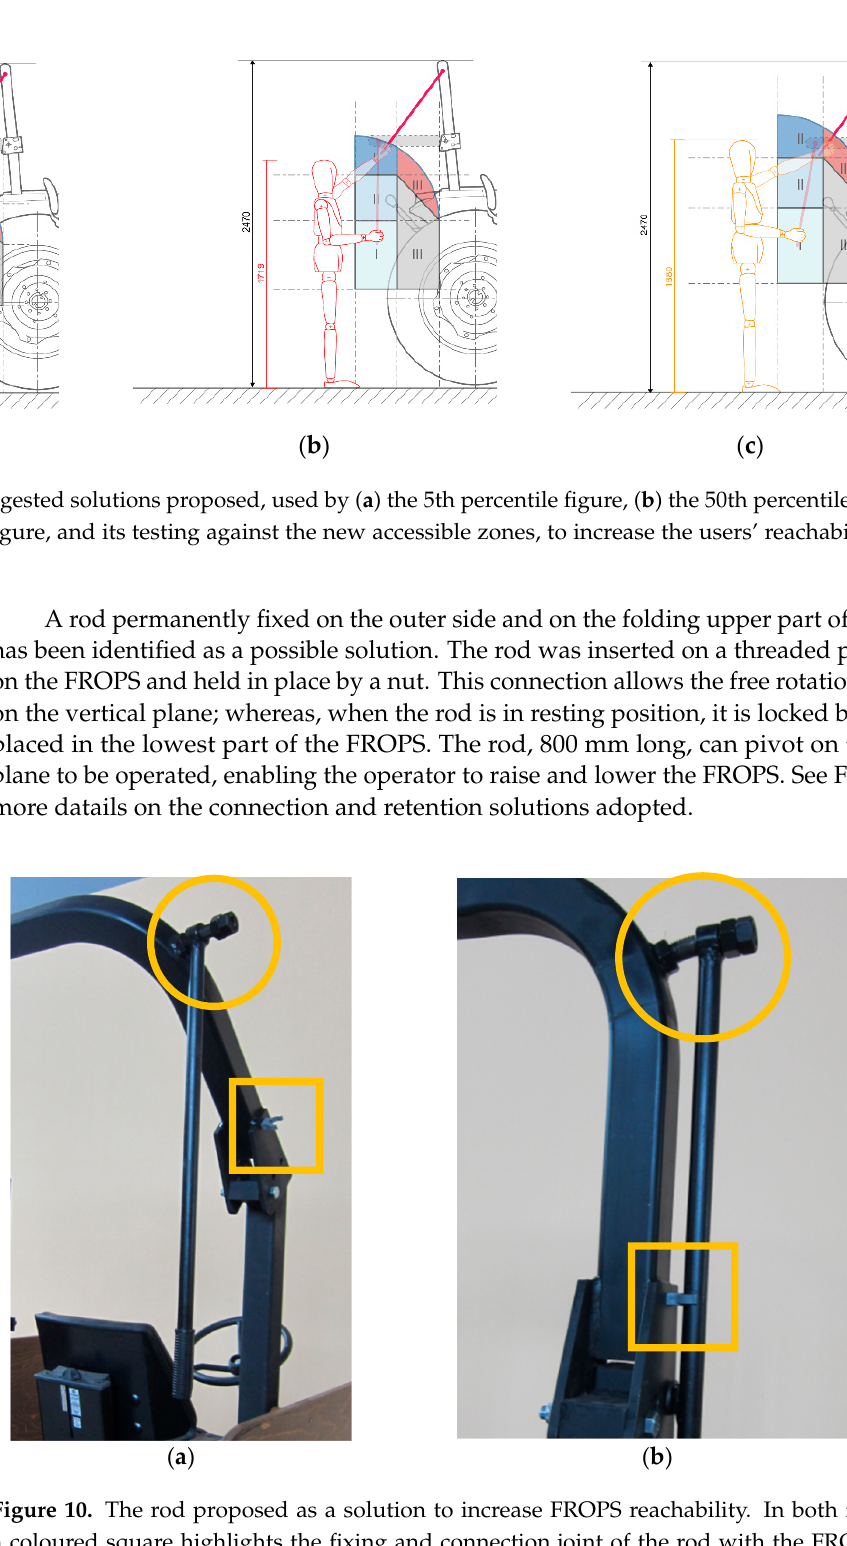
( c ) Figure 11. The three users corresponding to ( a ) the 5th percentile, ( b ) the 50th percentile, and ( c ) the 95th percentile in- volved in prototype testing, while performing the requested task of raising the FROPS. The redesigned accessible zones were overlapped to the photographs to verify their feasibility in actual conditions. Photographs taken while performing the raising task show that the 2D representa- tions made with manikins are rather loyal to the actual conditions. In detail, Figure 11 shows that all the participants belonging to the three percentiles considered could raise the FROPS standing safely with their feet on the ground, with the gripping point of the